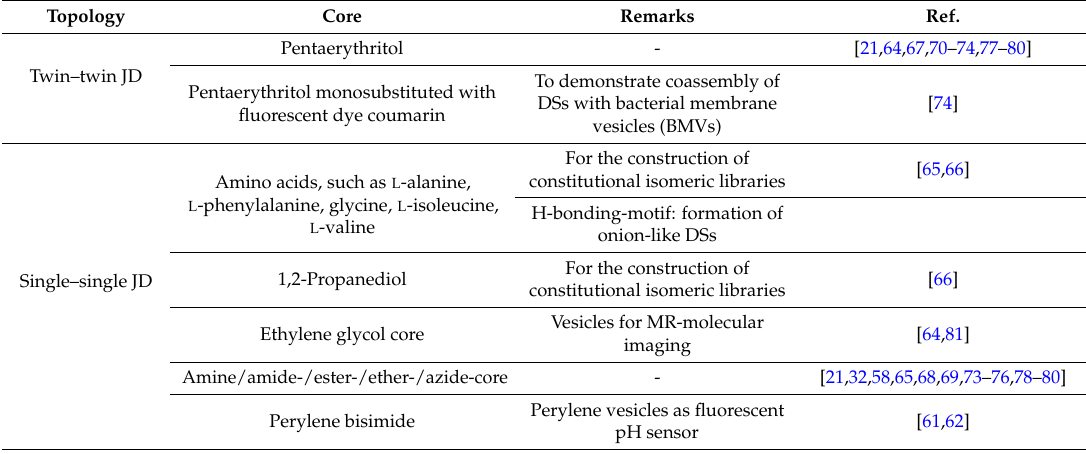
Table 4. Structural features of JDs self-assembling in aqueous environment: topology and core.